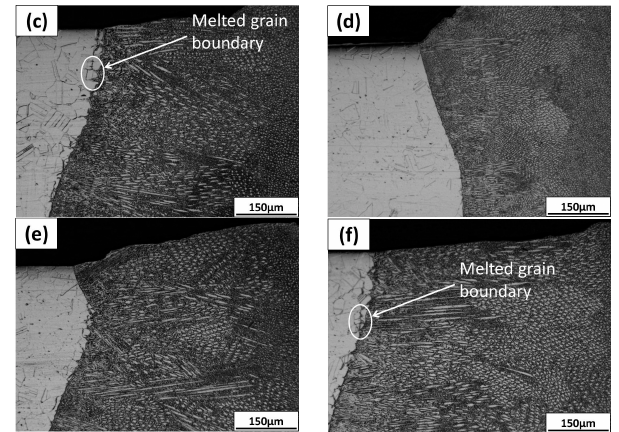
Figure 10. Variations of microstructure of the weld with pulse duration and frequency: ( a ) τ = 4 ms; ( b ) τ = 6 ms; ( c ) τ = 8 ms; ( d ) f = 50 Hz; ( e ) f = 70 Hz; ( f ) f = 90 Hz.